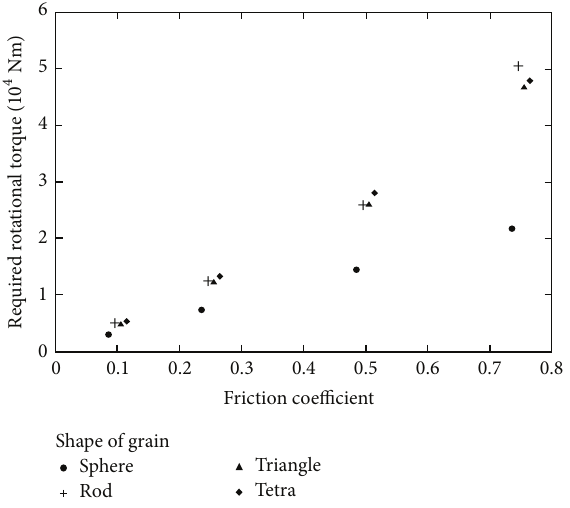
Figure 8: Rotation torque required for intergrain slipping. Table 3: Packing ratio of the tetrahedral-shaped grains. Friction